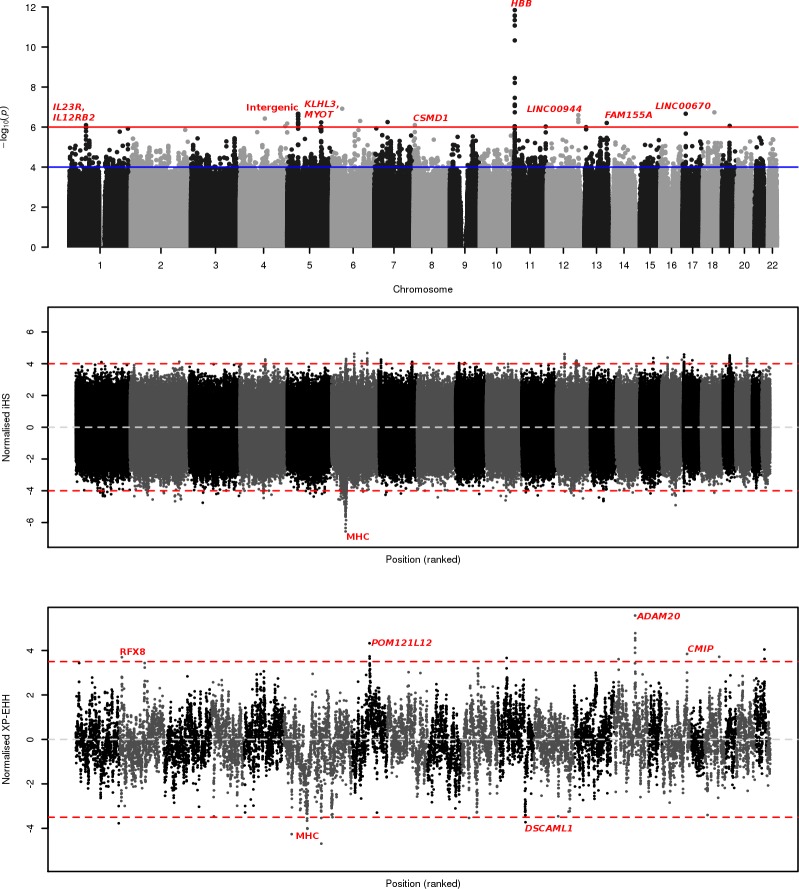
Genome-wide association and selection plots.a) Case-Control SNP Associations. Red line indicates genome-wide significance at 1x10-6, blue line indicates genome-wide suggestive significant at 1x10-4; b) Combined population iHS selection. Red lines indicate significance for absolute iHS scores of 4 or greater; c) Case-Control XP-EHH selection. Red lines indicate significance for absolute XP-EHH scores of 4 or greater.